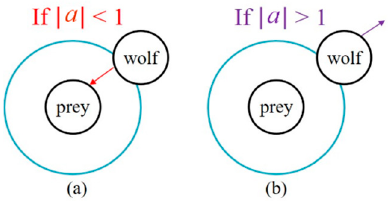
Figure 11. Position update in GWO algorithm.